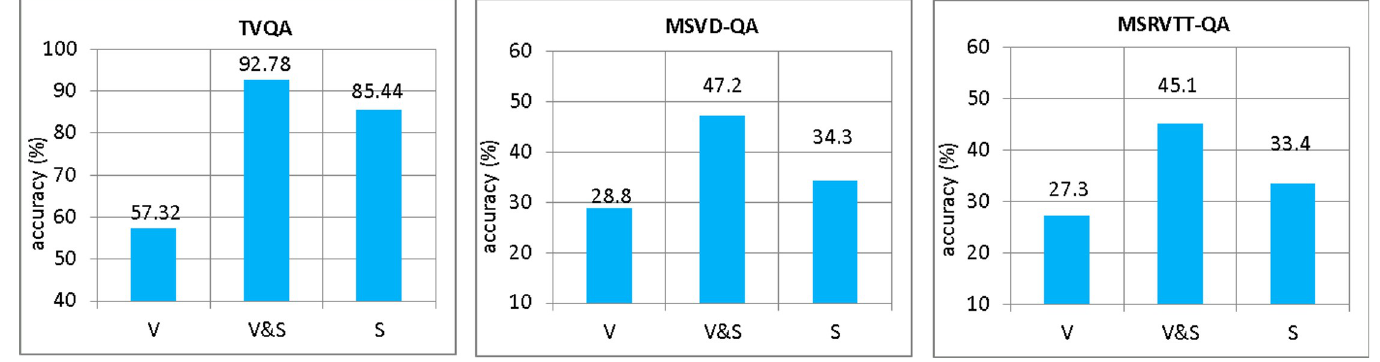
Fig 6. Analysis by required modality of